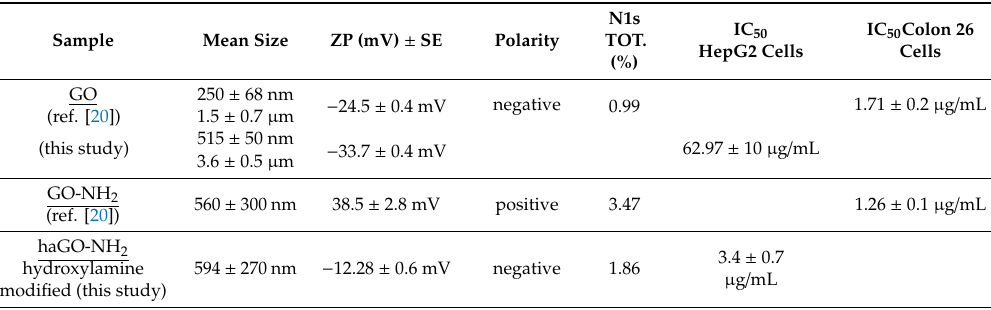
Table 1. Comparison between di ff erent types of GO and aminated GO NPs studied in this study and in Krasteva et al., 2019